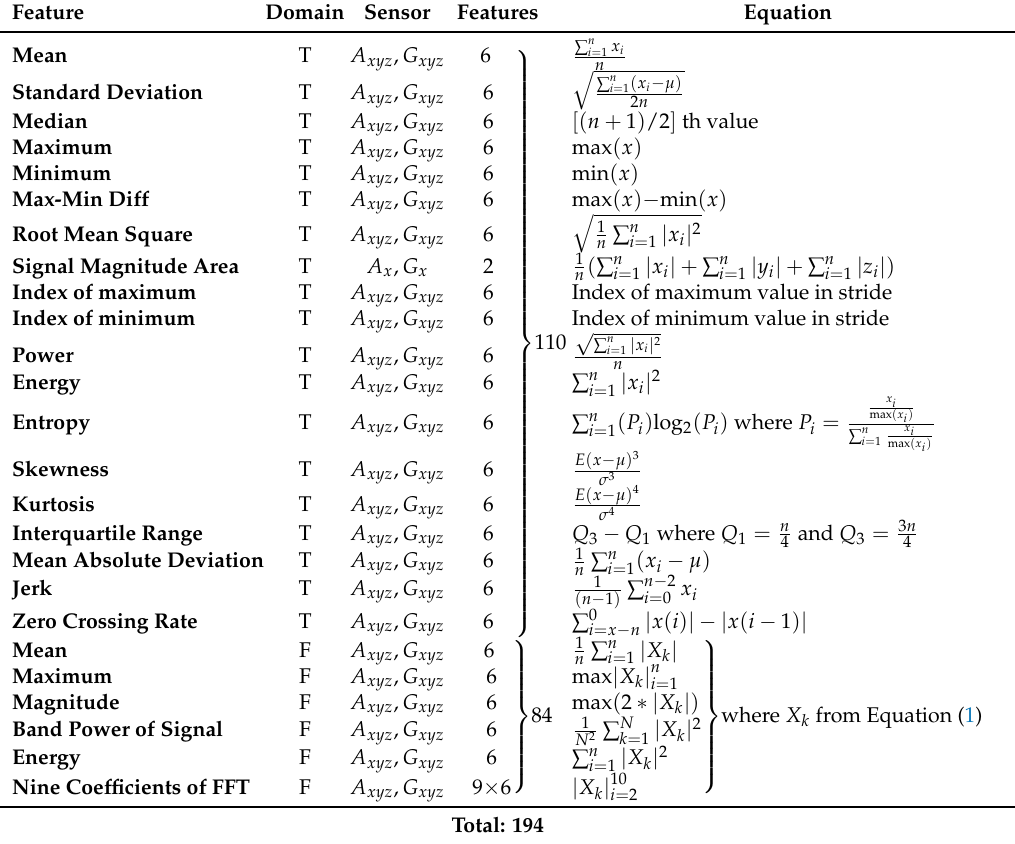
Table 5. List of hand-crafted features extracted from 6D accelerations and angular velocities for each stride. The features set consists of a total of 194 tempo-spectral features, of which 110 features were computed from the time domain (T) and 84 features were computed from the frequency domain